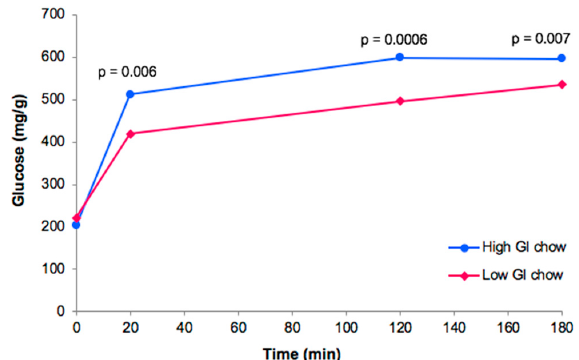
Figure 1. Rate of starch digestion for the high GI and the low GI diets. Rate of digestion was determined by the Englyst procedure [31]. Diets were tested in duplicate on three separate occasions.